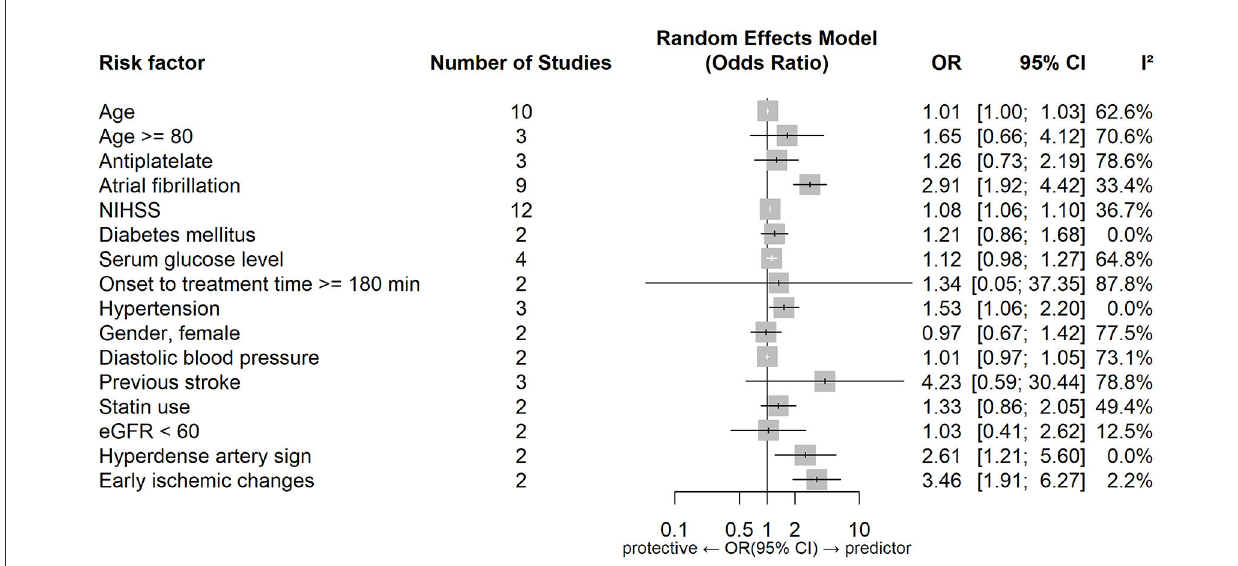
FIGURE2 Forest plot of predictors for any ICH after IVT. OR, Odd Ratio; CI, Confidence Interval; NIHSS, National Institute of Health Stroke Scale; eGFR, estimated Glomerular Filtration Rate.